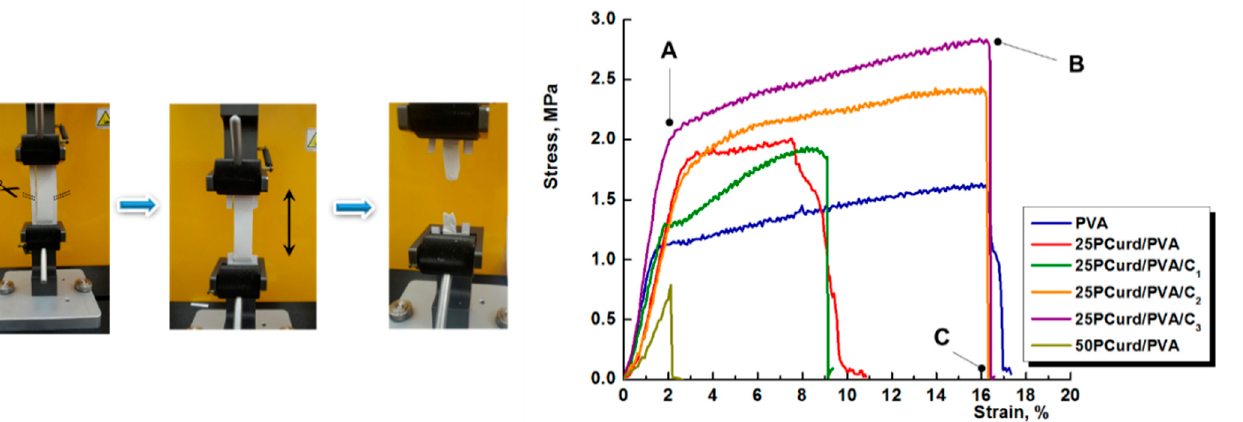
Figure 5. The release profile of clove essential oil from 25PCurd/PVA/C electrospun membrane at 32 °C and pH 5.5.